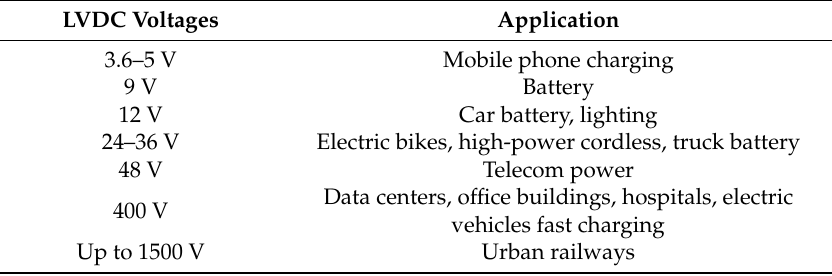
Table 1. Low-voltage DC distribution network (LVDC) voltages and applications